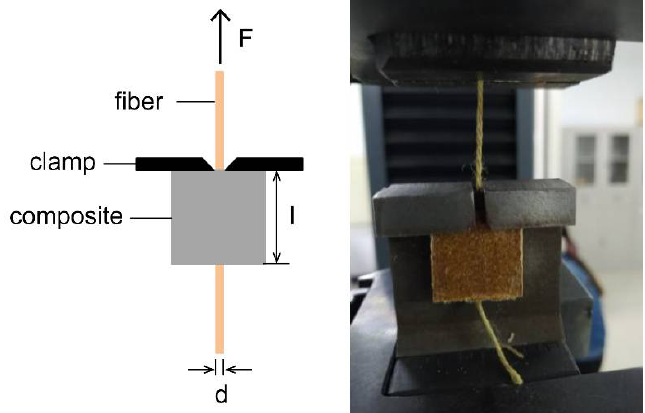
Figure 2. Illustration of the CAF reinforced WPCs pull-out